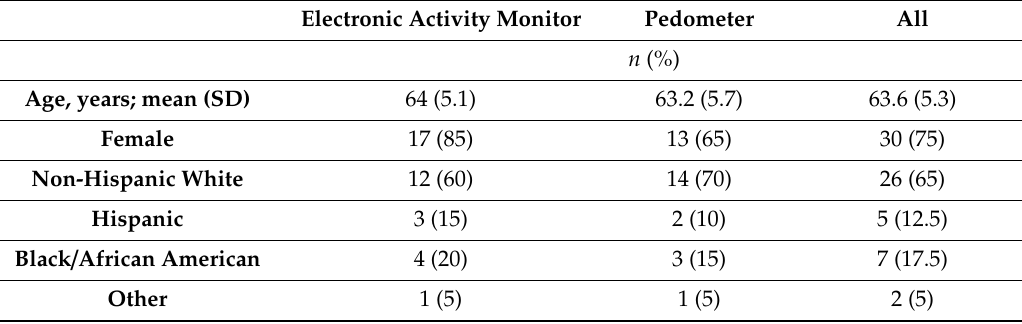
Table 1. Demographic information by study group ( n = 40).